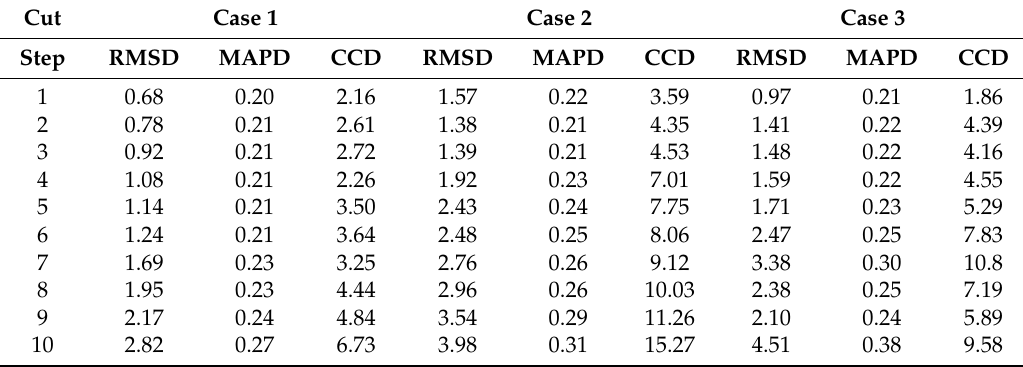
Table 3. RMSD, MAPD and CCD values (%) calculated for metal disc PZT attachment method. Cut Case 1 Case 2 Case 3